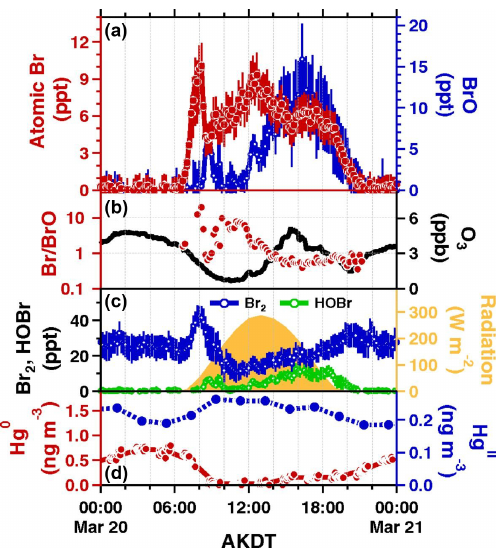
Figure 3. Time series at Utqia˙gvik on 20 March 2012 of measured (a) atomic bromine (Br) and bromine monoxide (BrO), (b) Br / BrO ratios, and O 3 . Error bars represent propagated measurement uncer- tainties. From Fig. 2 in Wang et al. (2019)(EPS figure provided for the